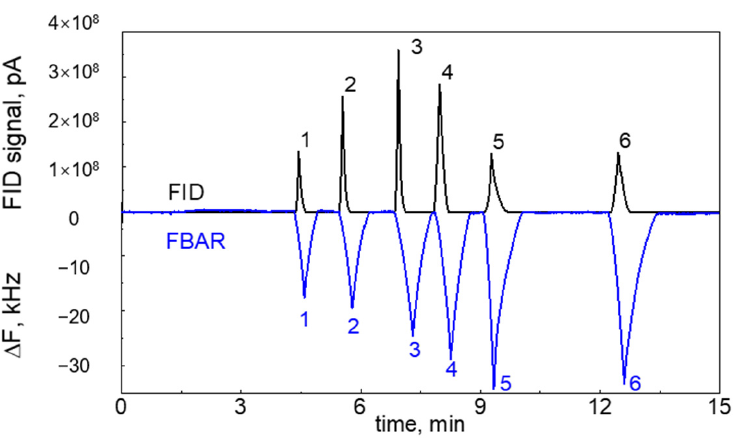
Figure 5. Chromatographic separation and mFBAR sensor as well as FID detection of six mixed chemical compounds. Simultaneous chromatogram traces from a mFBAR sensor (blue, bottom) and a downstream FID (black, top). 1: Ethanol; 2: Acetone; 3: Toluene; 4: Heptane; 5: DMMP; 6: MS. The proportion of the six analytes was 1 µ L: 1 µ L: 1 µ L: 1 µ L: 0.1 µ L: 0.1 µ L, split ratio = 10:1. The oven temperature was set as T initial = 50 ◦ C, ramp = 15 ◦ C min − 1 , T final = 230 ◦ C. Constant helium gas flow = 1 mL min − 1 .